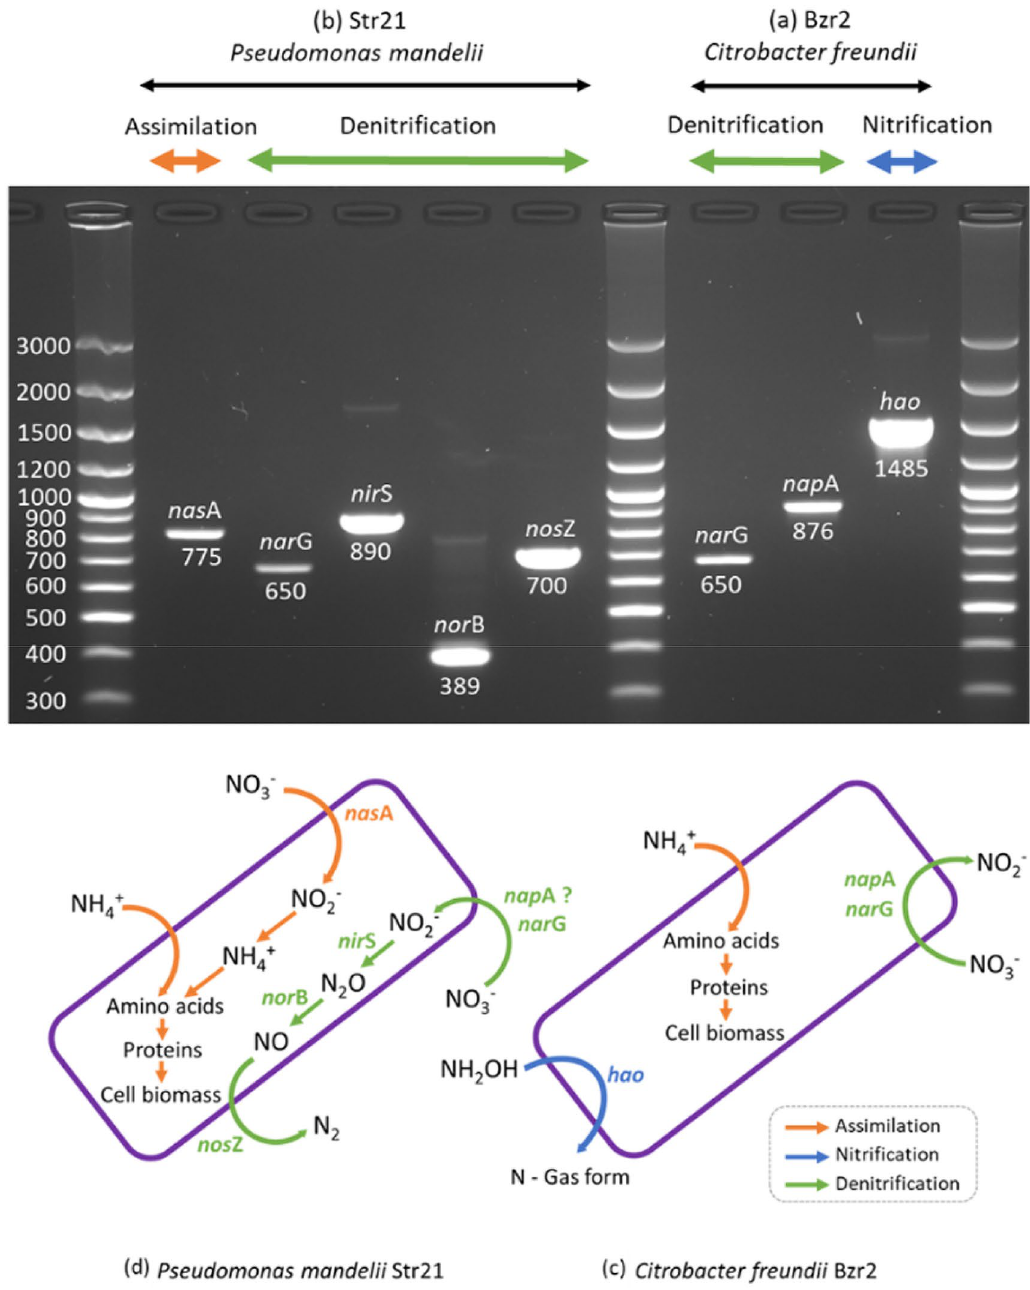
Figure 4. PCR amplification of key functional genes involved in nitrogen transformations for bacterial strains ( a ) Str21 and ( b ) Bzr02, and the predicted nitrogen utilization pathways in ( c ) Str21 and ( d )